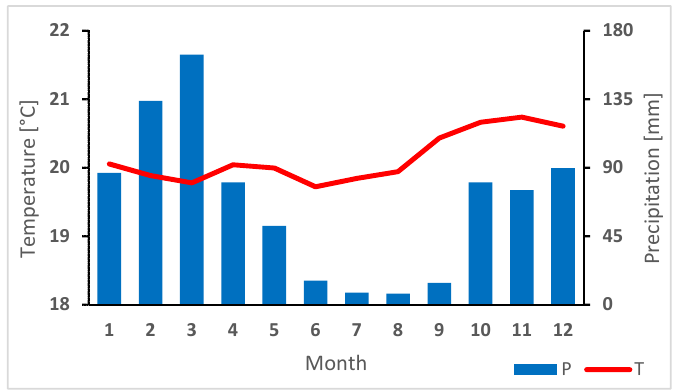
Figure 2. Climograph of the station Malacatos (M0143), province Loja - Ecuador (period: 2006-2015).